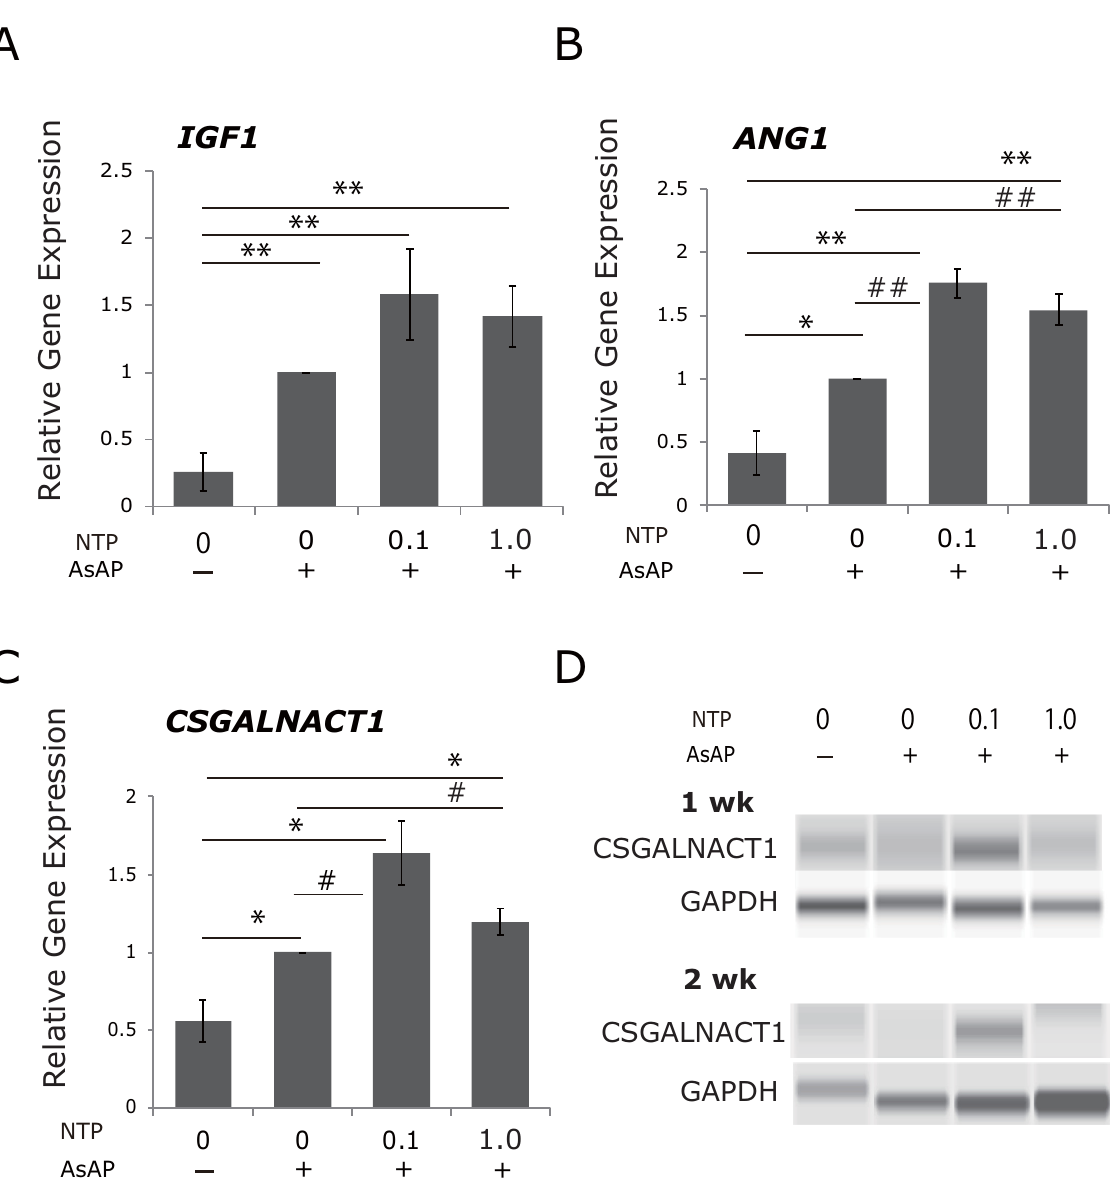
Fig 5. Upregulation of IGF1 , ANG1 ,and CSGALNACT1 expression by NTP treatment. Based on the results of the microarray, relative mRNA expression of IGF1 , ANG1 ,and CSGALNACT1 was assessed by real-time quantitative PCR. Samples were prepared form one-week-cultured cells, treated as indicated. A-C) Addition of AsAP with or without NTP upregulated expression of these three genes in comparison with control samples. A) The co-treatment with NTP (0.1 or 1.0 mNU/ml) and AsAP tended to increase IGF1 compared to AsAP alone. B) The co-treatment with NTP (0.1 or 1.0 mNU/ml) and AsAP increased ANG1 significantly compared to AsAP alone. C) The co-treatment with NTP (0.1 mNU/ml) and AsAP increased CSGALNACT1 significantly compared to AsAP alone. Data are normalized to GAPDH and presented as the average ± standard error ( (cid:3)(cid:3) p < 0.01, (cid:3) p < 0.05 when compared with control, ## p < 0.01, # p < 0.05 when compared with AsAP alone, N = 5). D) Whole cell lysate prepared from one-week and two-week-cultured NP cells was analyzed by western blotting with an appropriate antibody (N = 1). Enhanced expression of CSGALNACT1 by the co-treatment with 0.1 mNU/ml NTP and AsAP in protein levels at one-week and two-week time points was detected. Staining for GAPDH was shown as loading